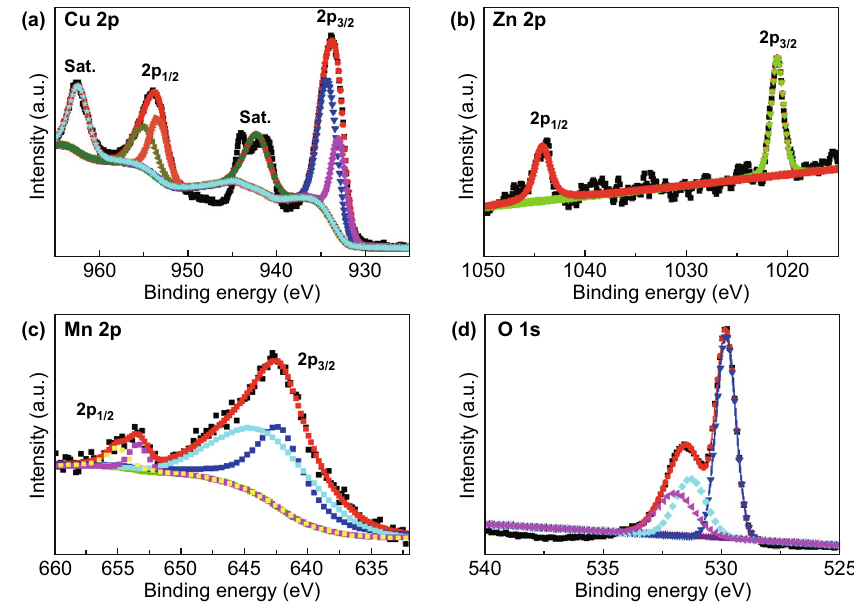
Fig. 2 a Cu 2 p, b Zn 2 p , c Mn 2 p and d O 1 s regions for Zn–CuO@MnO 2 core–shell nanowire array